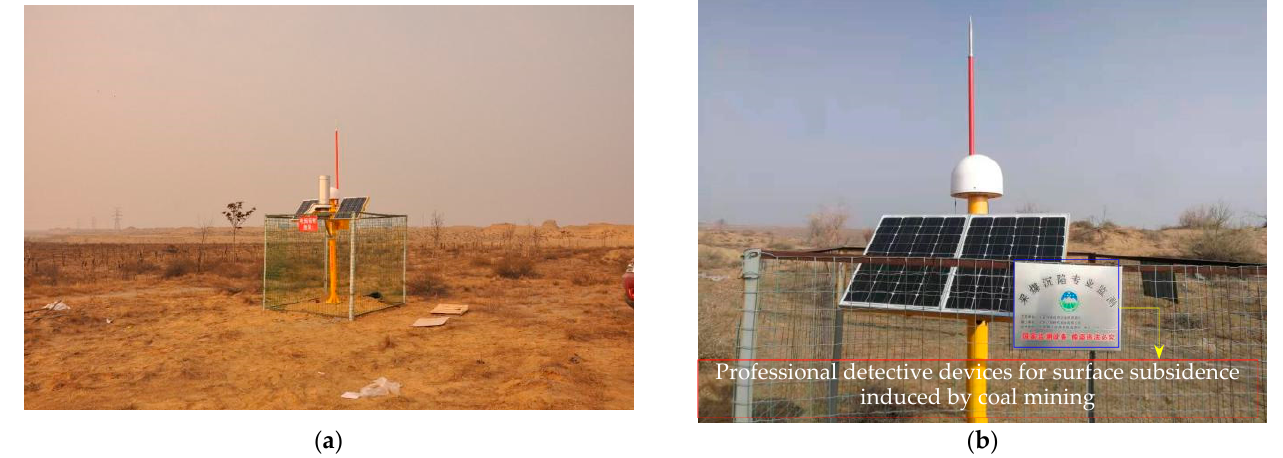
Figure 6. Photographs of surface sinking observation stations: ( a ) GNSS reference station, ( b ) Working station.